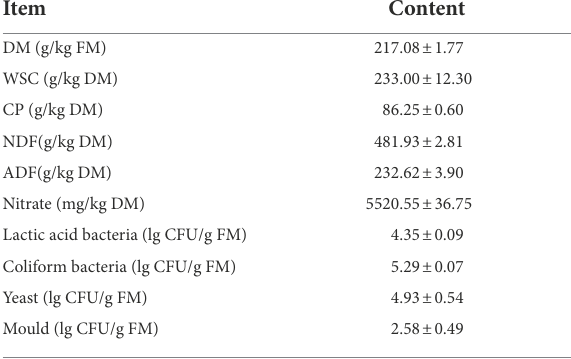
TABLE 1 Chemical composition and microbial counts in sorghum-